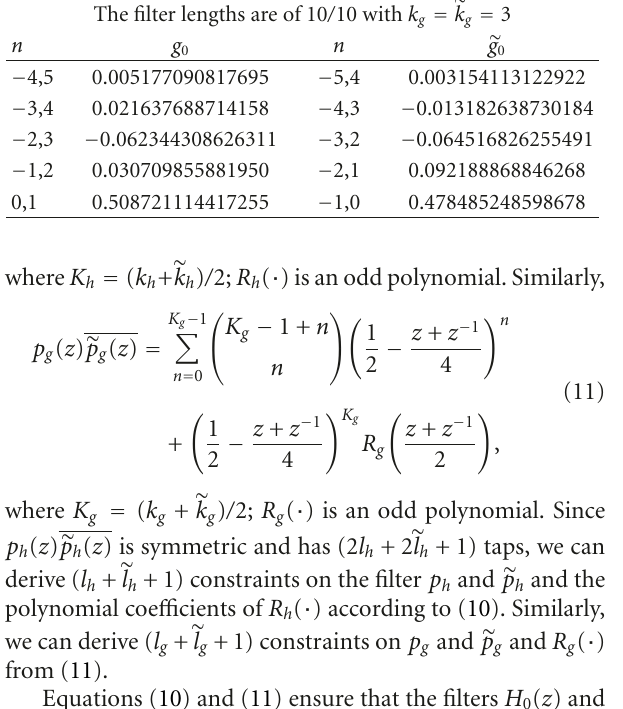
Table 3: The coe ffi cients of low-pass filters in Example 2. The filter lengths are of 10 / 10 with k g = (cid:2) k g =